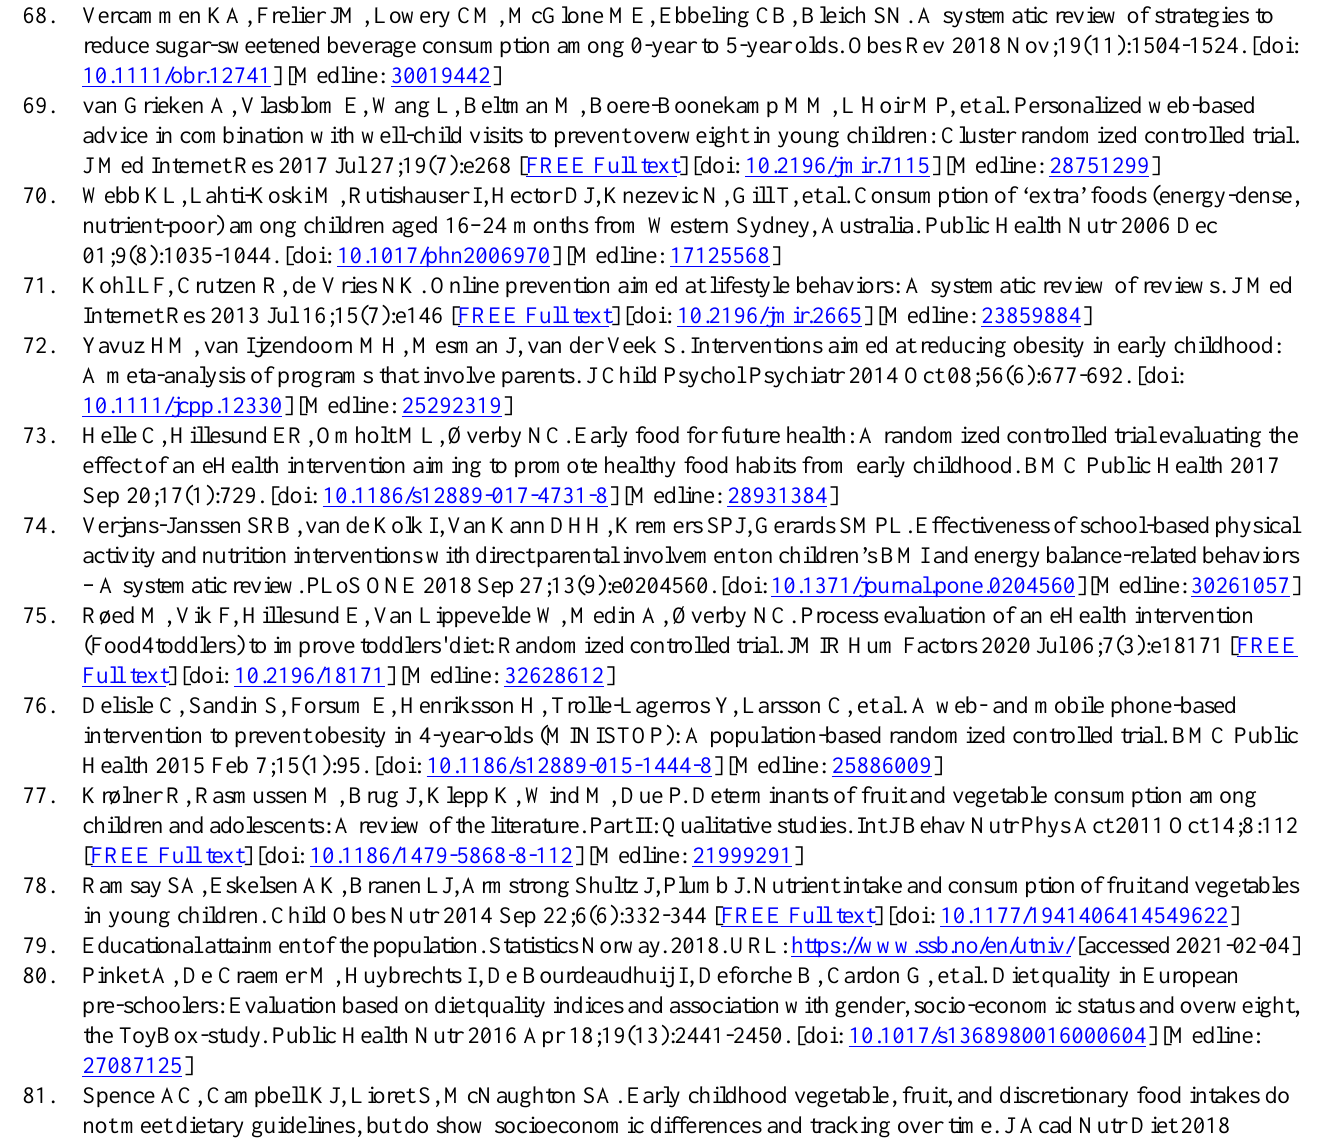
Abbreviations CONSORT-EHEALTH: Consolidated Standards of Reporting Trials of Electronic and Mobile HEalth Applications and onLine TeleHealth EMM: estimated marginal mean FFQ: food frequency questionnaire GEE: generalized estimating equation ISRCTN: International Standard Randomised Controlled Trial Number mHealth: mobile health MINISTOP: Mobile-based intervention intended to stop obesity in preschoolers RCT: randomized controlled trial WHO: World Health